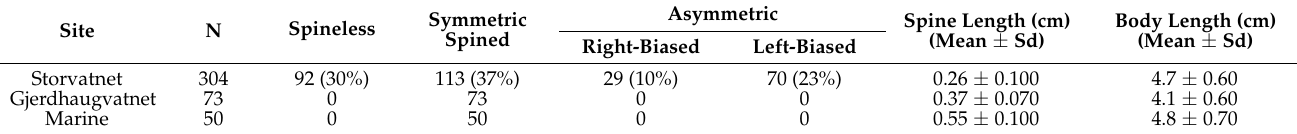
Table 1. Morphological measurements of threespine sticklebacks from the two freshwater lakes, Lake Storvatnet and Lake Gjerdhaugvatnet, and a marine site. The mean of pelvic spine lengths from Lake Storvatnet was calculated based on specimens with spines and asymmetric-spined specimens only. Pelvic scores (PS) were calculated for both the left and right side of the specimens and vary from 0–4. The combined pelvic score (CPS) is the sum of the PS from both sides and varies from 0–8. “N” is the total number of specimens from each location.